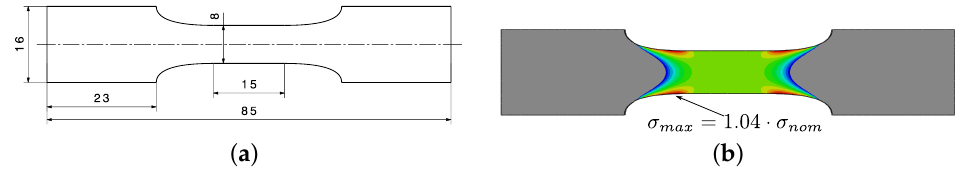
Figure 4. Thin-walled specimen for fatigue testing with a plate thickness of 1.5 mm. ( a ) Illustration of the thin-walled specimen geometry with main dimensions in millimetres. ( b ) Numerical analysis of stress concentration factor depicted as the maximum principal stress.